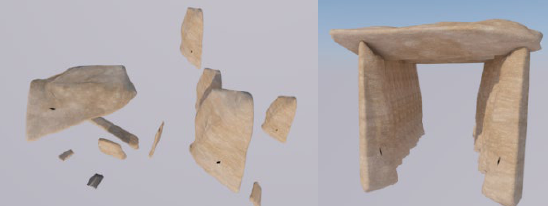
Figure 17. An ontology of synthetic megaliths (left) and hypothetical passage tomb reconstruction scenario involving passageway orthostats and lintels (left)